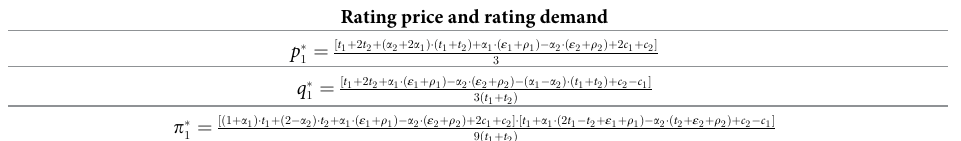
Table 3. Long-term equilibrium solutions of DRAs. Rating price and rating